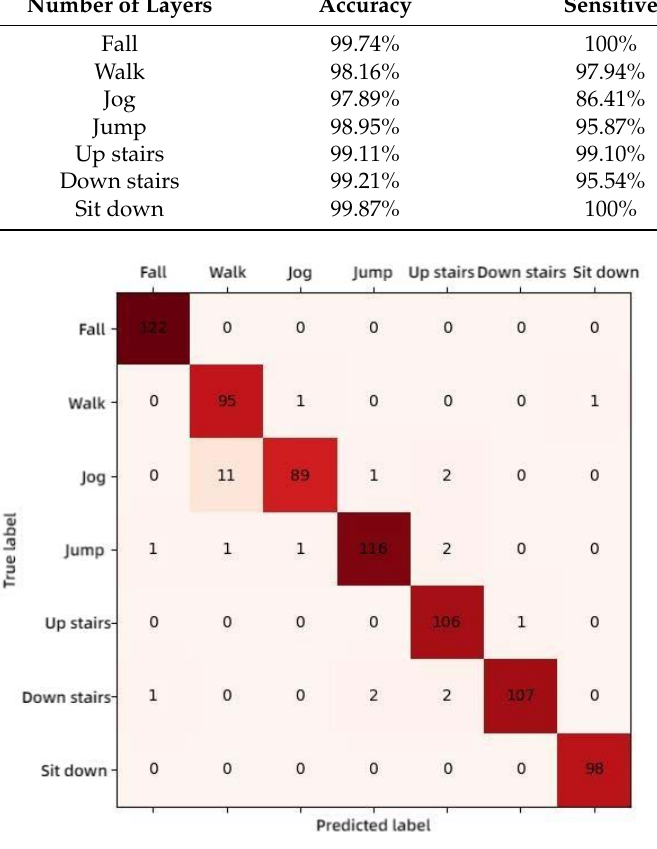
Figure 10. The test set’s confusion matrix.